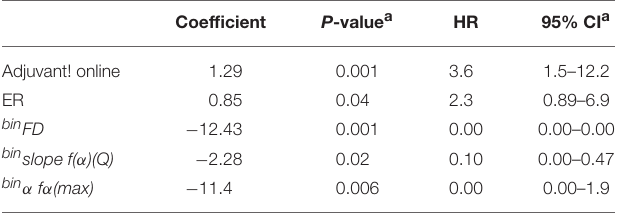
TABLE 2 | Multivariate Cox proportional hazards regression analysis. Coefficient P -value a HR 95% CI